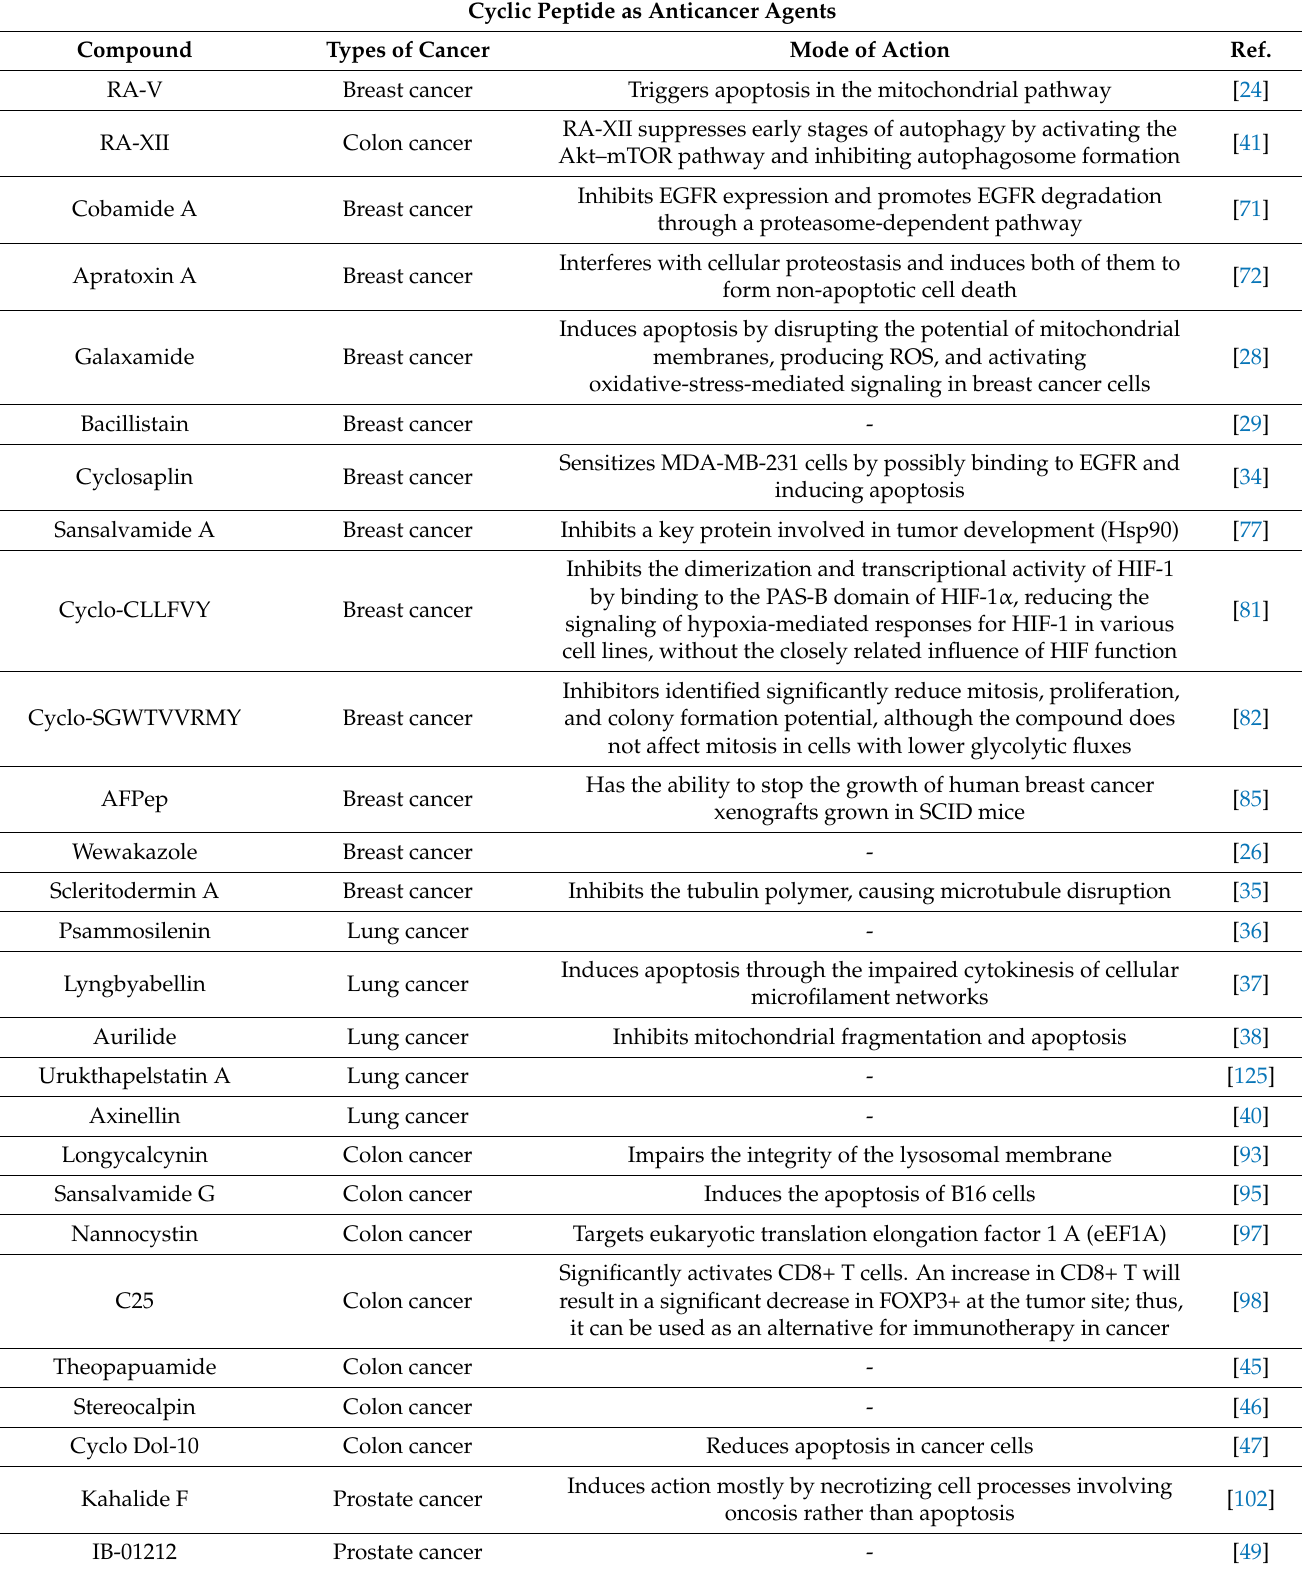
Table 2. Cyclic peptides as anticancer agents and their mechanisms of